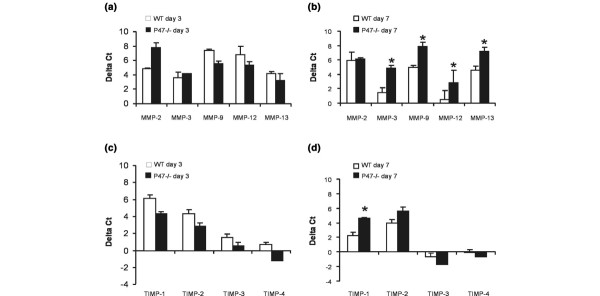
mRNA levels of various MMPs and TIMPs in synovia derived from inflamed knee joints. Inflamed synovia were isolated 3 days (a,c) and 7 days (b,d) after IFN-γ-accelerated arthritis. The cycle threshold value (Ct) of the various MMP (a,b) and TIMP (c,d) genes was corrected for glyceraldehyde-3-phosphate dehydrogenase content and for values at zero time. Note that at day 7 significantly elevated levels of MMP-3, MMP-9 and MMP-13 were found in p47phox-/- mice in comparison with controls (b). TIMP-1 and 2 were also somewhat elevated, although to a lesser extent than MMP (d). No significant differences were found at day 3 (a,c).